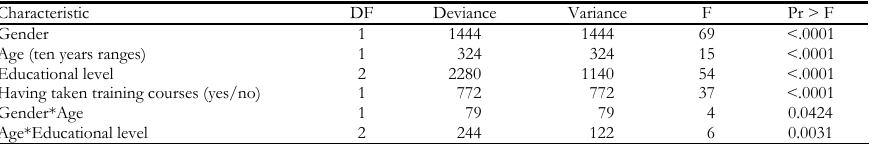
Analysis of variance results for the score test